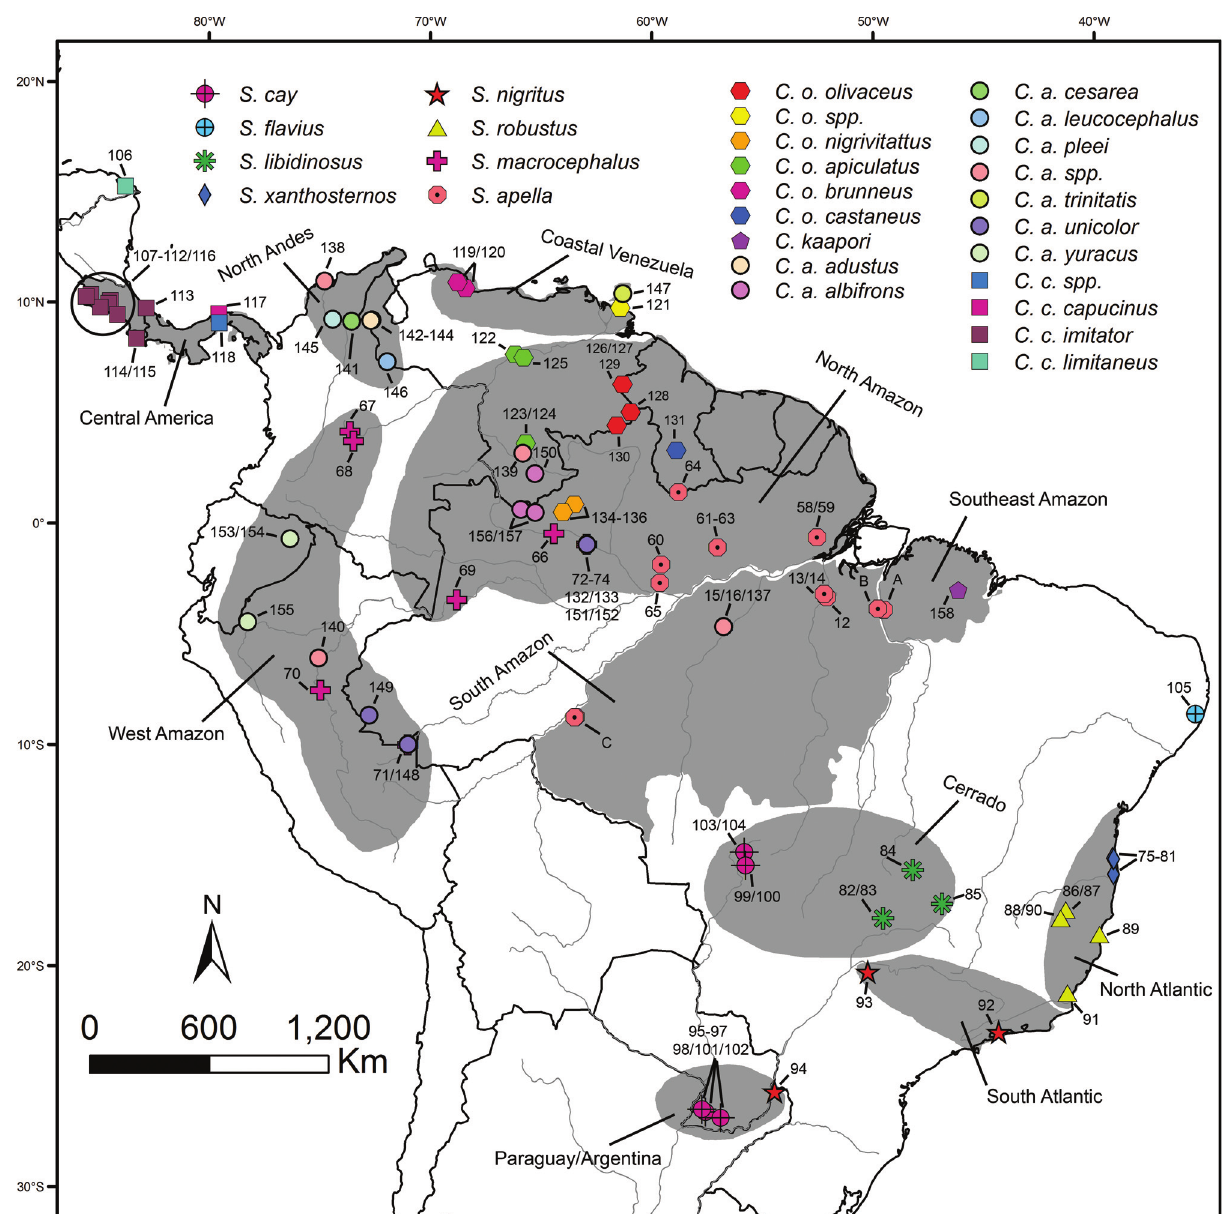
Figure 2 - Biogeographic zones analyzed (gray spots) and the collection sites of the Cebus and Sapajus samples. A = samples 1-4; B = samples 5-11; C =